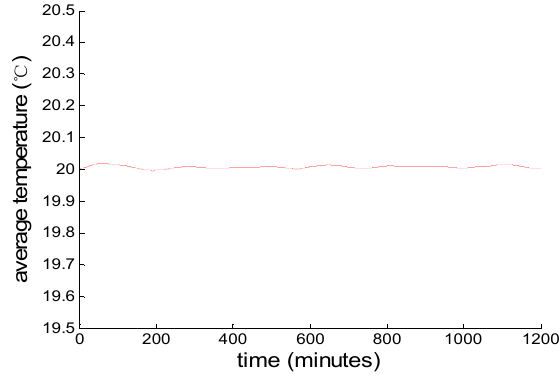
Figure 11. The temperature of 30 random air-conditioned rooms among the population.